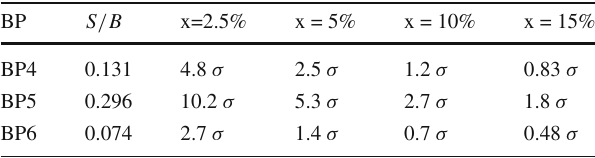
Table 14 The S / B ratio and signal significance for the benchmark points at 13 TeV with L = 3000 fb − 1 , in the b ¯ b + / E T final state, using BDT with 2.5%, 5%, 10% and 15% systematic